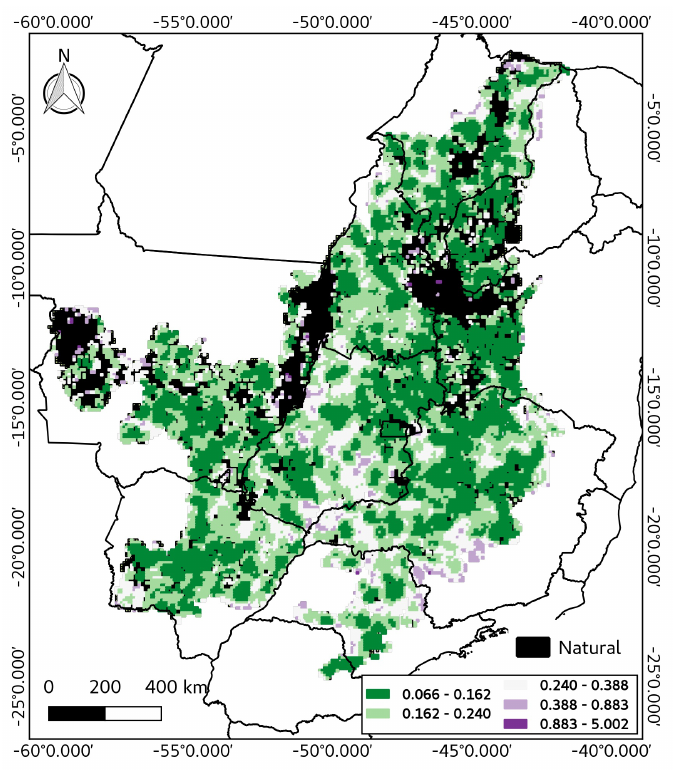
Figure 9. Standard error of the logarithmic form of rural